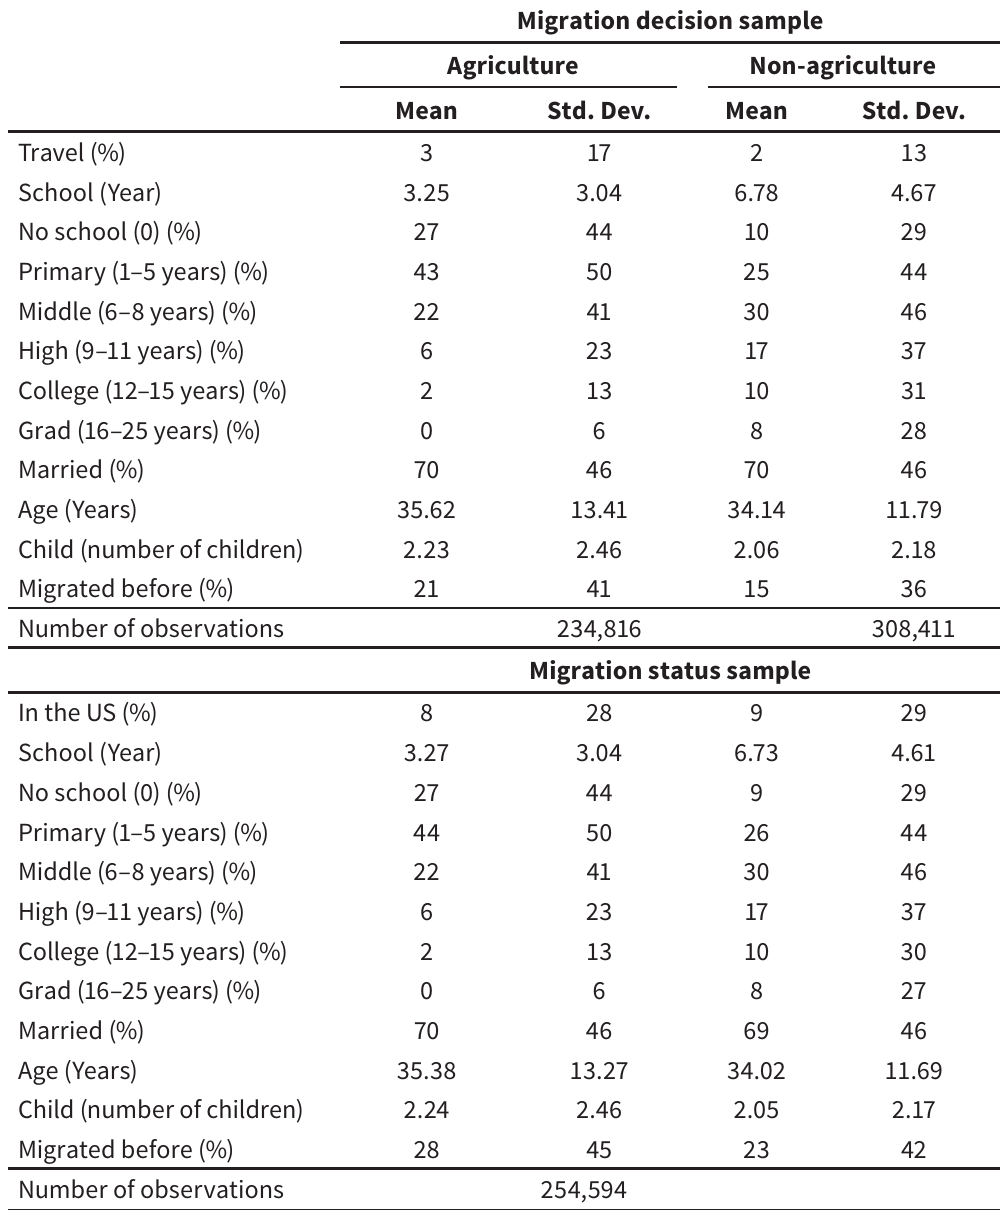
Table A3 Summary statistics of male household heads (agriculture versus. non-agriculture). Migration decision sample Agriculture Non-agriculture Mean Std. Dev. Mean Std.